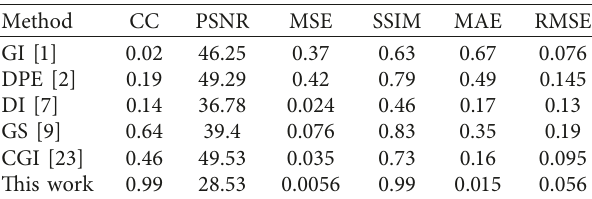
Table 2: Comparative performance of previous works.